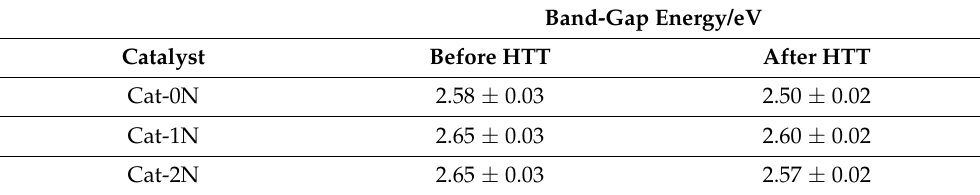
Figure 3. Kubelka-Munk functions of catalysts Cat-0N (solid blue), Cat-1N (solid red), Cat-2N (solid green), Cat-0N-0H (dashed blue), Cat-1N-0H (dashed red), and Cat-2N-0H (dashed green). Table 1. The band-gap energies of different catalysts determined from Tauc-representation [40] of KM-functions (Figure S2).